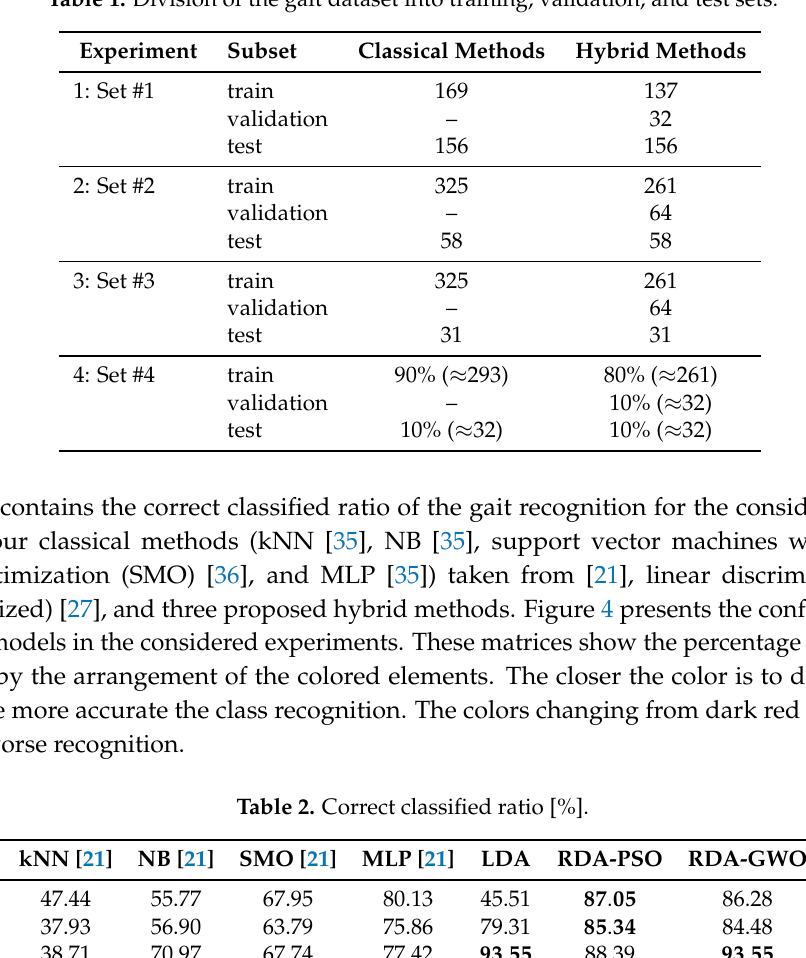
Table 1. Division of the gait dataset into training, validation, and test sets.